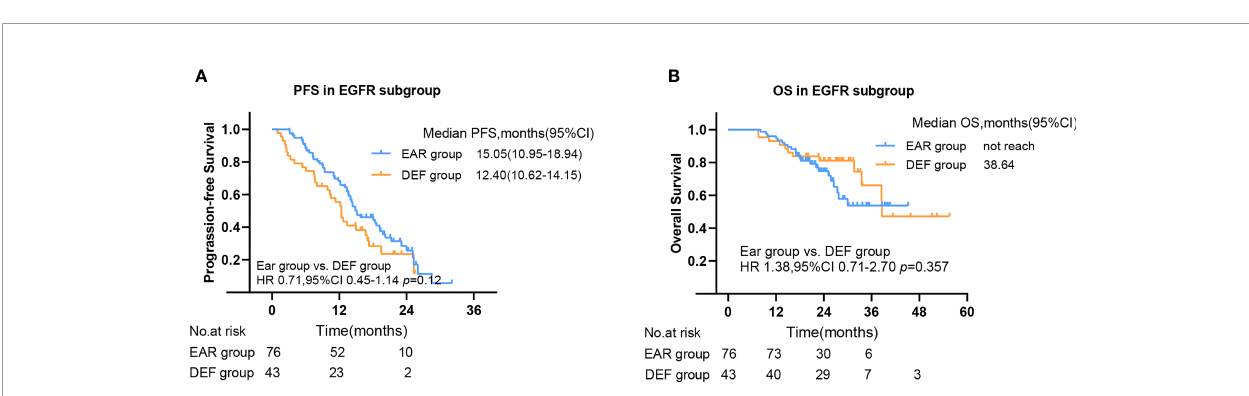
FIGURE 6 | The PFS (A) and OS (B) in EGFR mutant subgroup. PFS, progression-free survival; OS, overall survival; CI, con fi dence interval, EAR, early to initiate radiotherapy group ( ≤ 53 days); DEF, deferred radiotherapy group (>53 days).